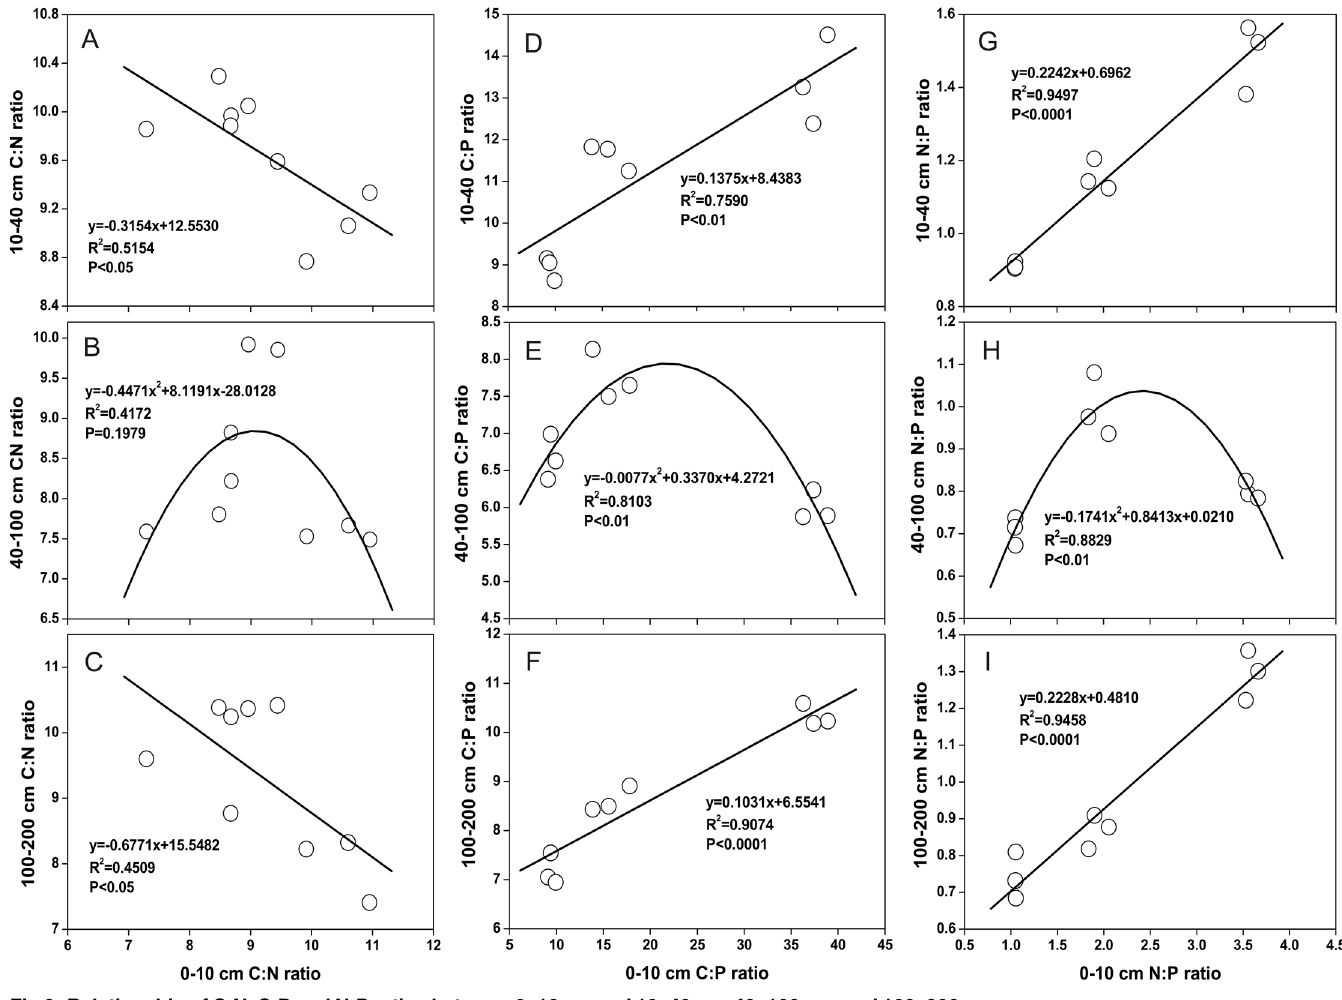
Fig 6. Relationship of C:N, C:P and N:P ratios between 0 – 10 cm and 10 – 40 cm, 40 – 100 cm, and 100 – 200